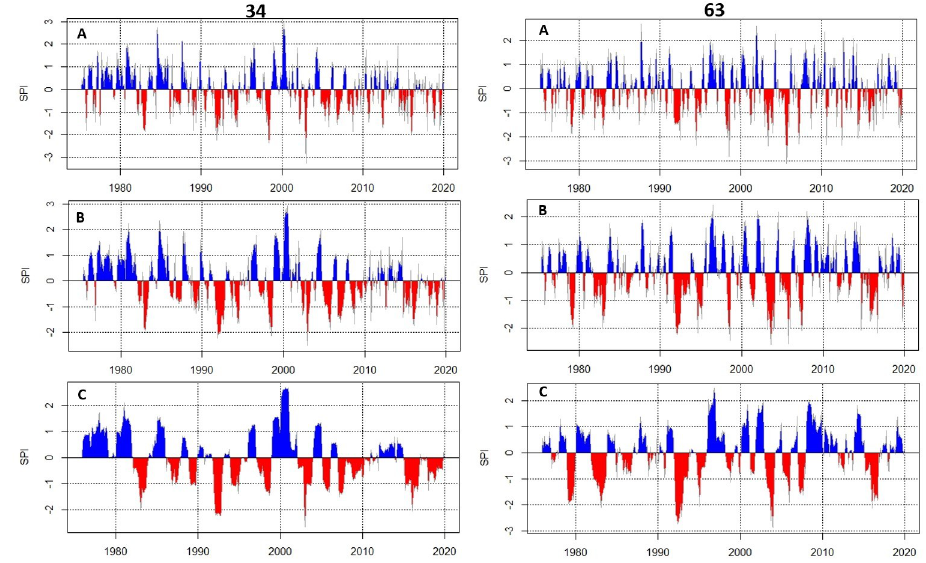
Fig 3. The Standardized Precipitation Index for (A) 2-, (B) 6-, and (C) 12-month accumulation period for two homogenous rainfall regions districts 34 and 63 of the Olifant River Catchment from